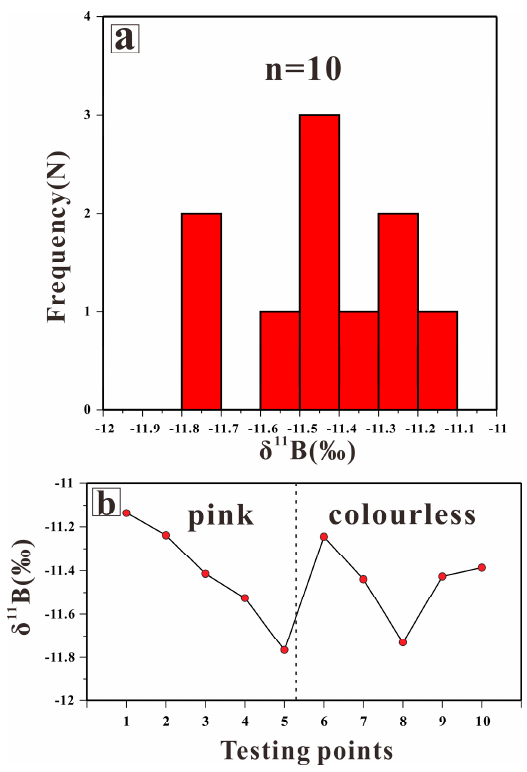
Figure 6. ( a ) Frequency histogram of boron isotope compositions of tourmaline; ( b ) δ 11 B values from the pink part to the colourless part. the pink part to the colourless